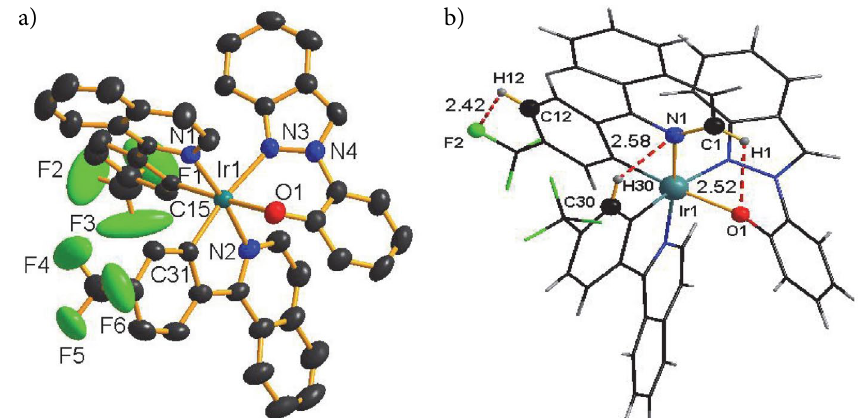
Fig. 1. (a) ORTEP view of 2b with the atom-numbering scheme at the 50% probability level. Hydrogen atoms and solvent molecules are omitted for clarity. (b) Selected non-covalent contacts of the C–H···O, C–H···F and C–H···N types (dashed red lines). Atoms involved in hydrogen bonds are shown as balls of arbitrary radii. All other atoms and covalent bonds are represented as wires or sticks.